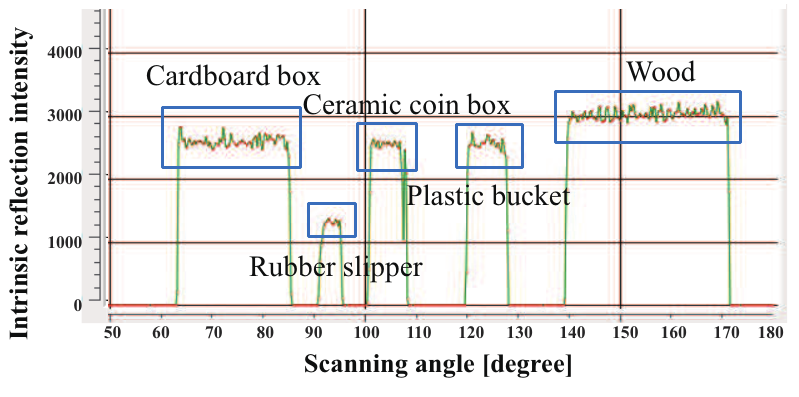
Figure 7. Normalized reflection intensity value of each object.